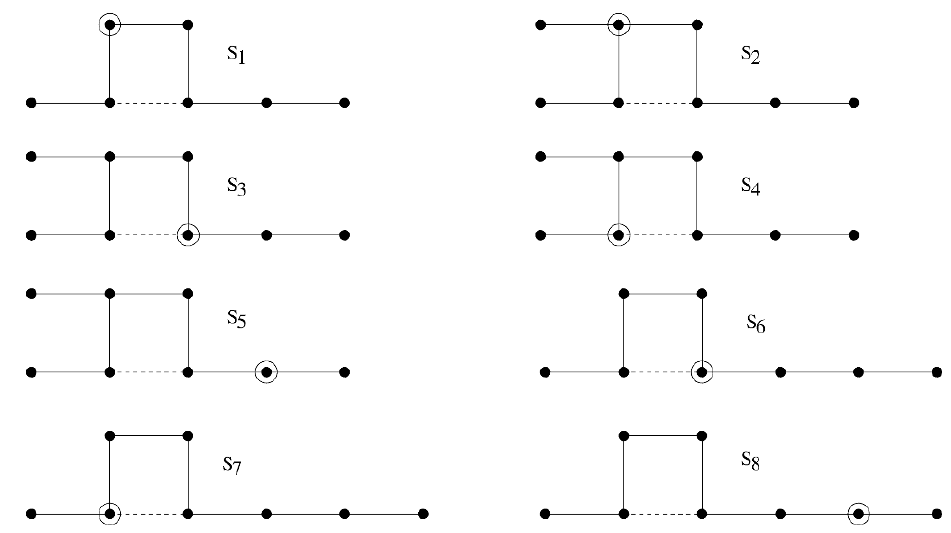
Figure 2. The distinguished-vertex signed graphs S while the broken edges correspond to an entry − 1 . The distinguished vertices are